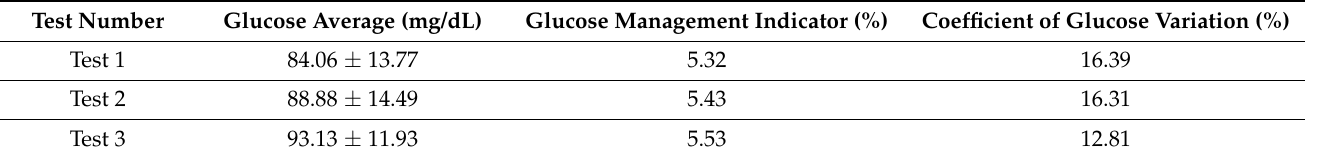
Figure 2. Glucose measurements in each test developed. Table 4. Glucose statistics at the end of each test.